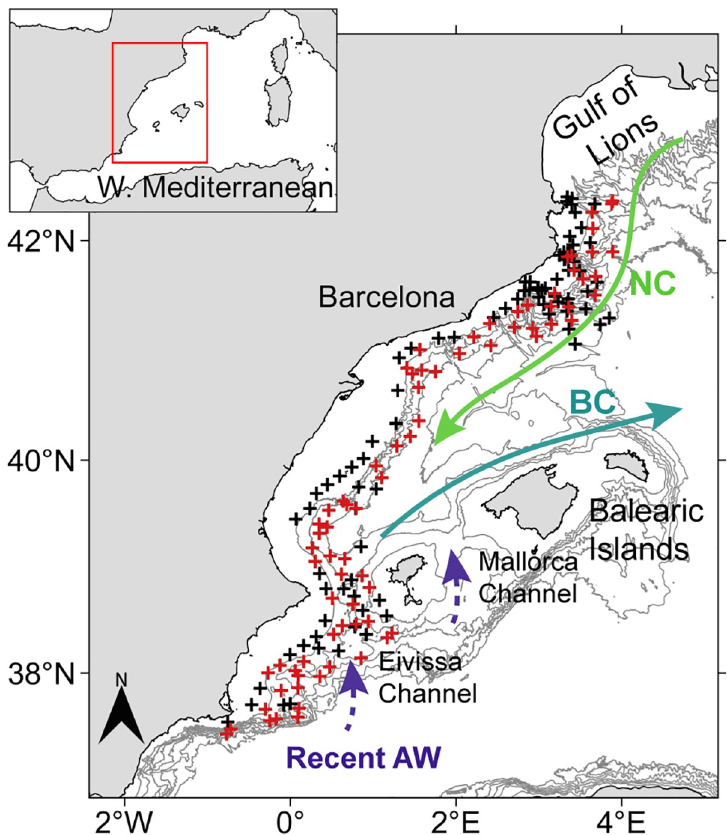
Fig 1. Study area in the Western Mediterranean. Hydrographic (black and red crosses) and plankton (red crosses) stations during the survey. The schematic lines indicate the main currents, Northern Current (NC) and Balearic Current (BC), and recent AW inflow through the Eivissa and Mallorca Channels. Coastline is from Natural Earth [41] and Instituto Hidrogra´fico de la Marina [42], and isobaths (every 400 m depth) are from European Marine Observation and Data Network (EMODnet,